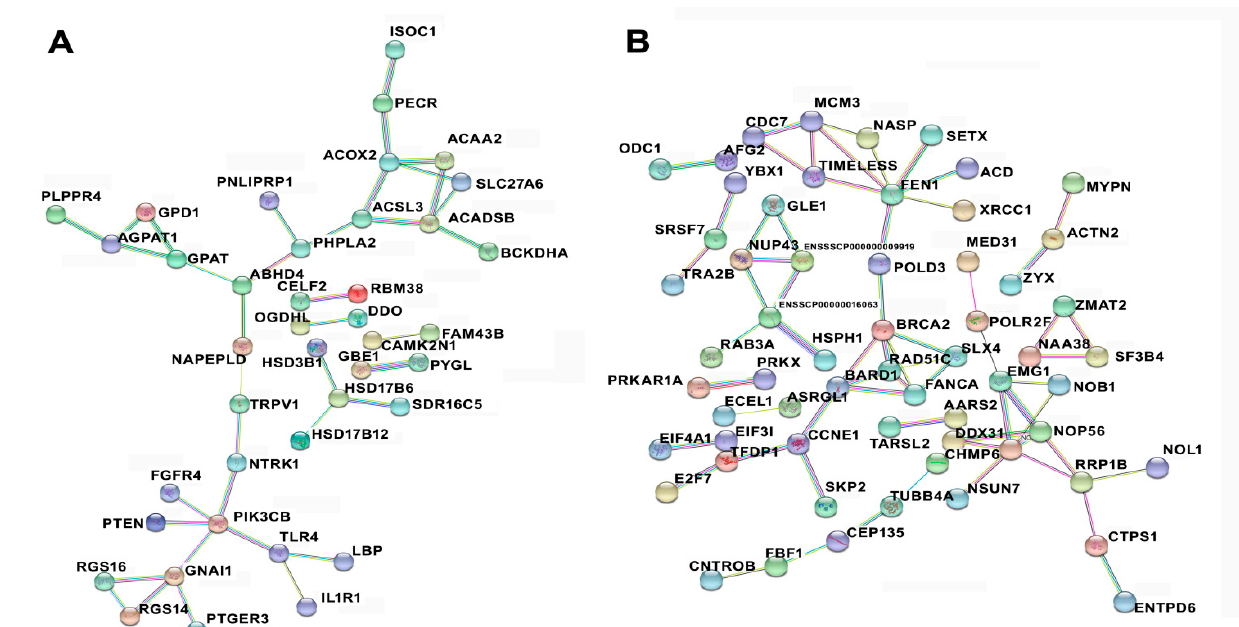
Figure 7. Protein–protein interaction network of differentially expressed mRNAs. ( A ) Probable functional network of mRNAs in profiles 1, 2, and 11. These genes were related to the regulation for lipid metabolism. ( B ) Probable functional network of the mRNAs in profiles 4 and 7. These genes were related to the regulation for cell cycle and genetic information